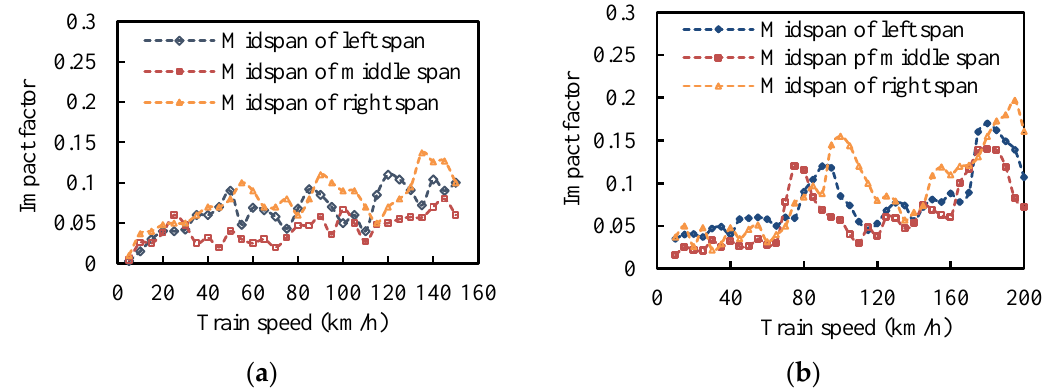
Figure 18. Impact factors calculated from deflections (track irregularity is considered) under: ( a ) one freight train; ( b ) one passenger train.